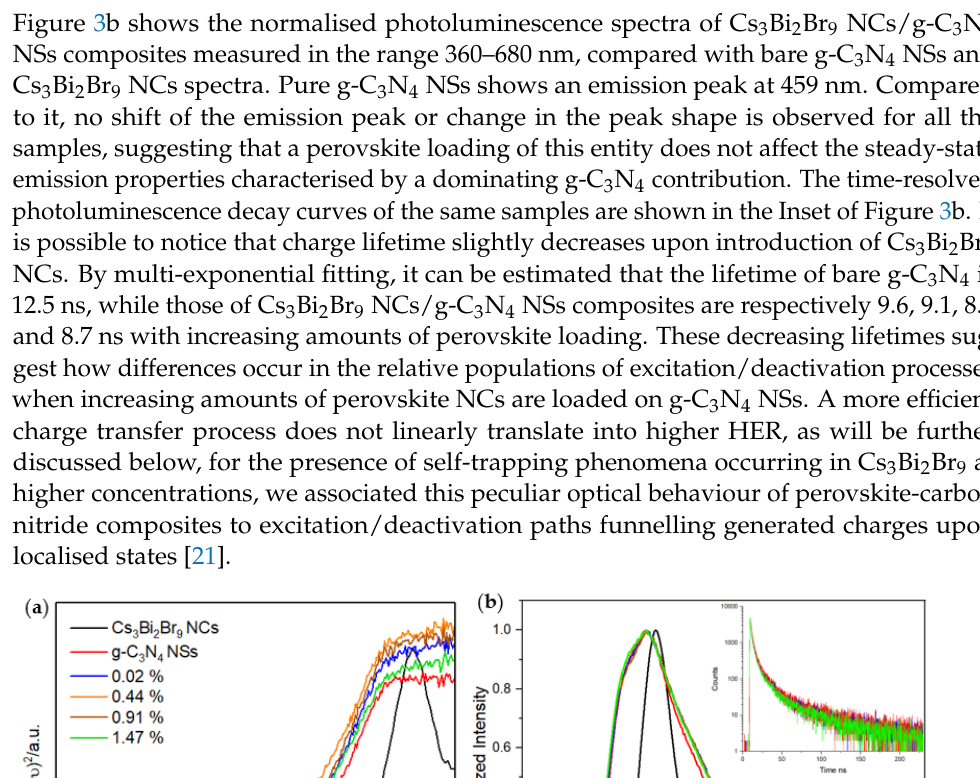
originated from the bridging nitrogen atom with tertiary C atoms, N–(C)3. The peak at 401.1 eV can be indicative of –NH x groups. The weak peak at 404.3 eV can be attributed to C 3 N 4 in air. Figure 4c,d show the separation of the spin ‐ orbital components for the Bi (4f 7/2 , 4f 5/2 ) and Br (3d 5/2 , 3d 3/2 ), the values were 5.32 eV and 1.05 eV, which indicate the oxidation